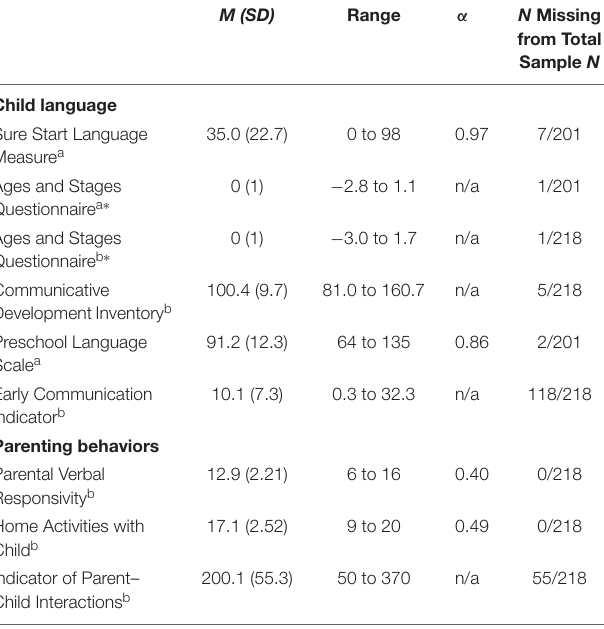
TABLE 3 | Descriptives for parent-reported and directly measured behaviors.